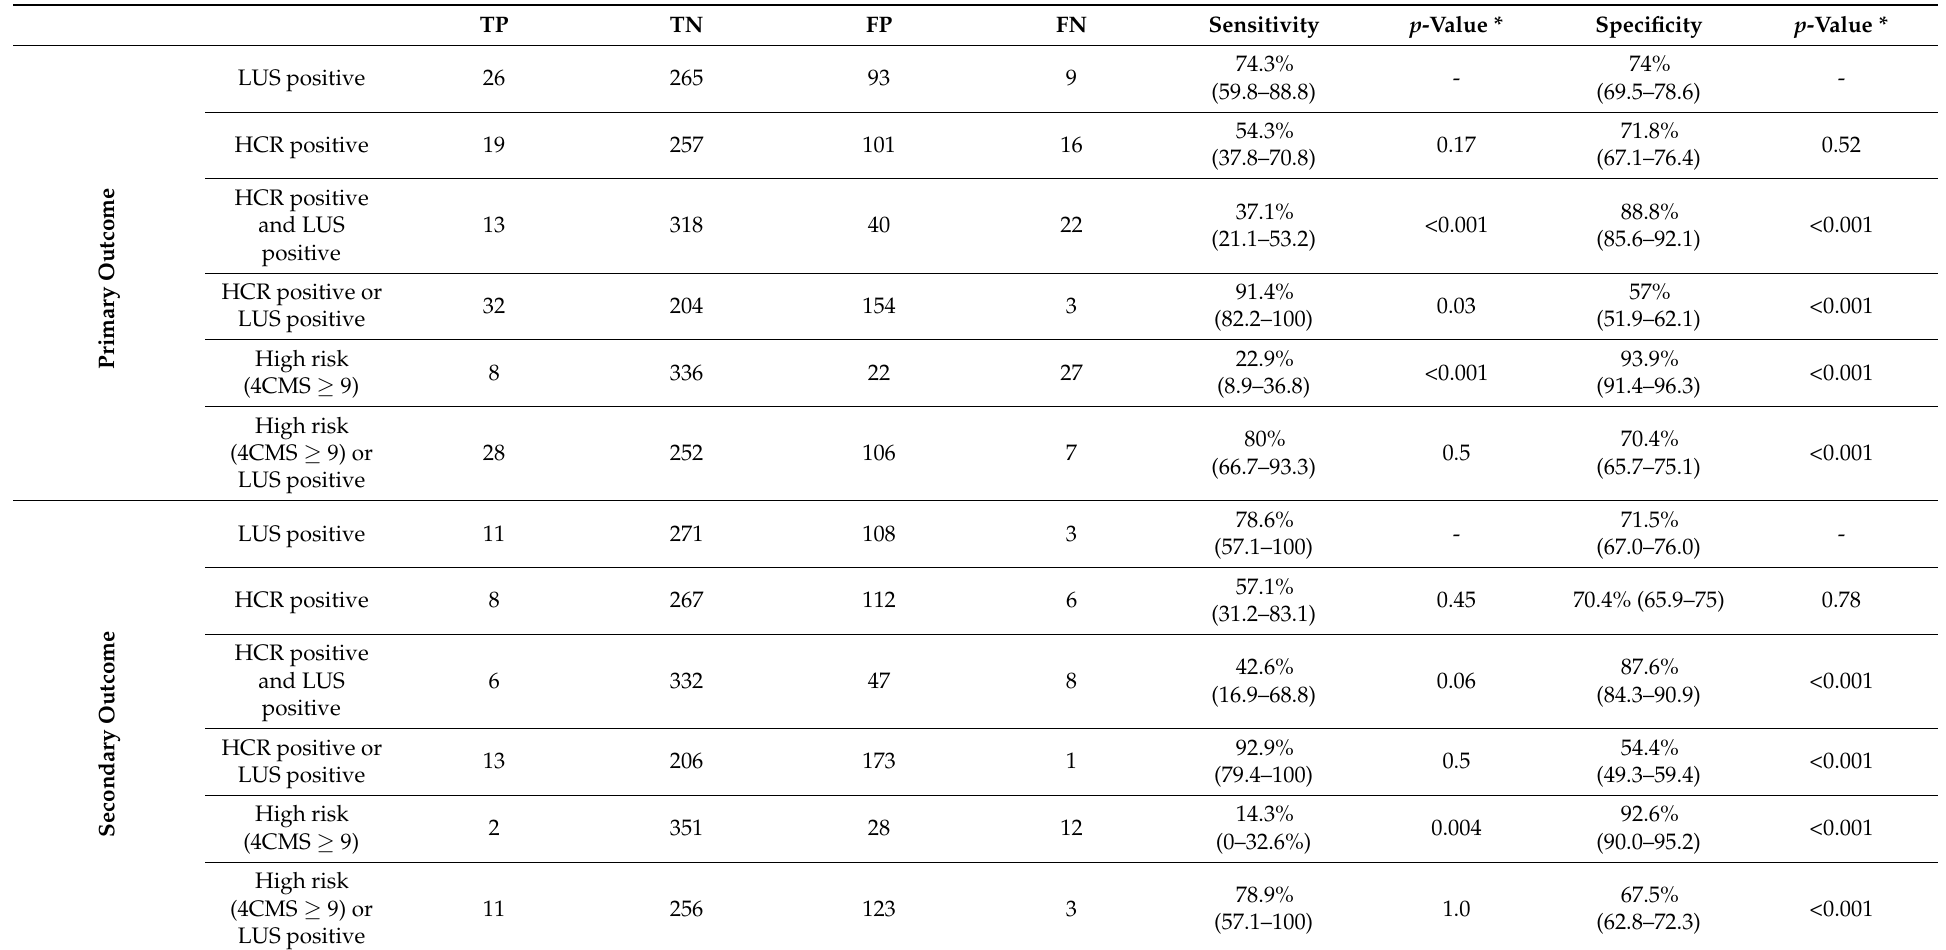
Table 1. Outcome prediction performance for the primary and secondary